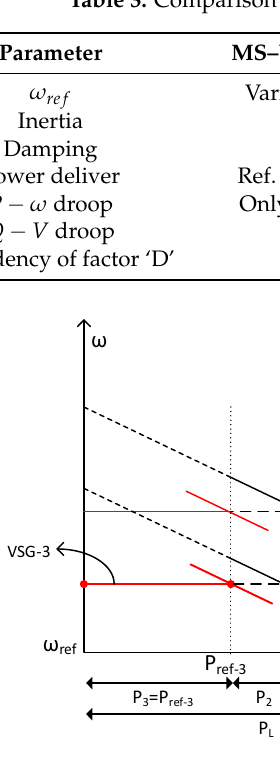
Figure 9. P ω− droop curve for master–slave configuration. Figure 9. P − ω droop curve for master–slave